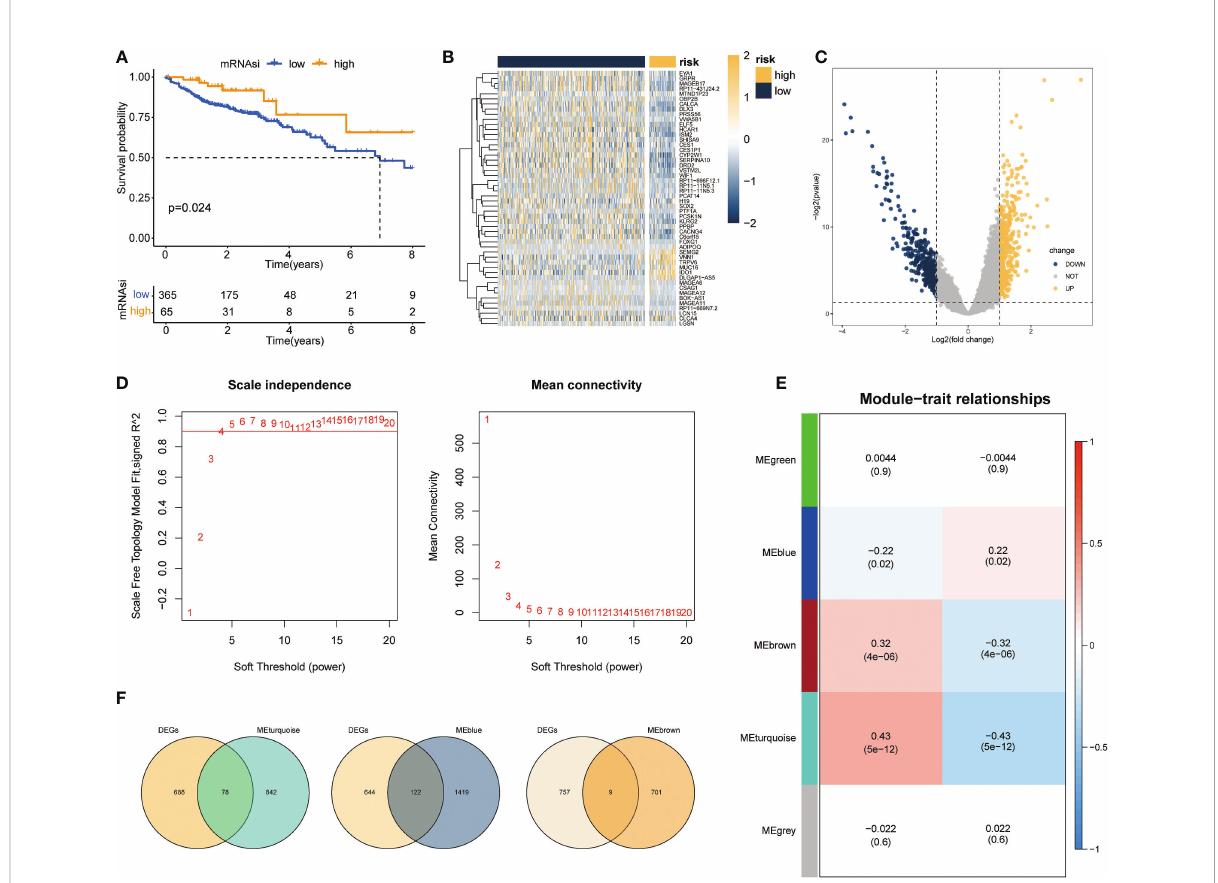
FIGURE 3 Screening of genes associated with necroptosis. (A) Survival analysis results revealed marked difference in survival status between groups with high and low necrotizing apoptosis scores (log-rank P =0.024); (B, C) Volcano maps and heat maps revealing DEG expression among COAD samples in the groups with high and low necrotizing apoptosis. (D) Quality control result selected by WGCNA softpower as 4. (E) Set of genes associated with the necroptosis phenotype analyzed and screened using WGCNA. The heat map demonstrated the correlation and signi fi cant difference between different gene modules and necroptosis score, where the P values are shown in parentheses. (F) Intersection of DEGs and genes in the signi fi cant module of